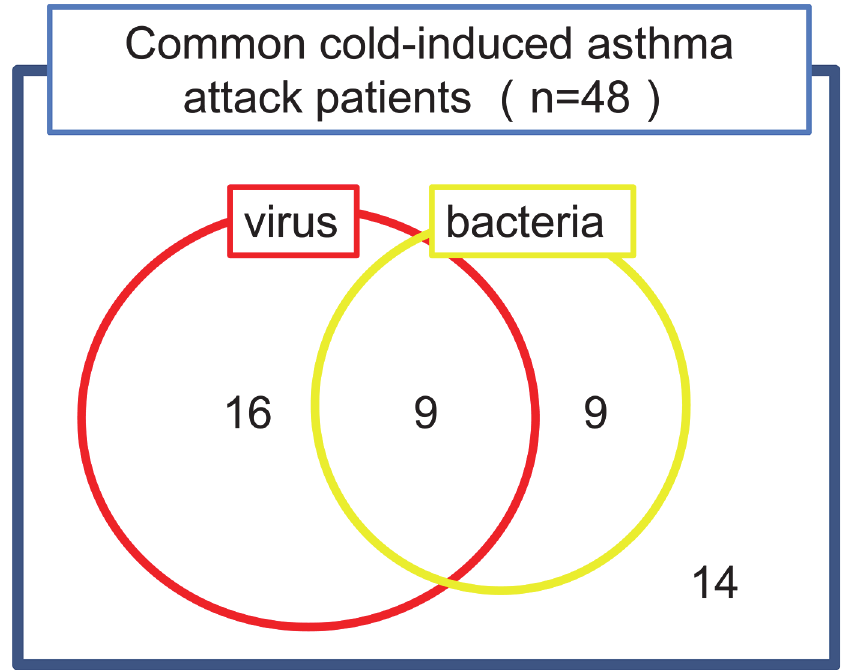
Fig 1. Pathogen detection from asthma exacerbation patients after a common cold.